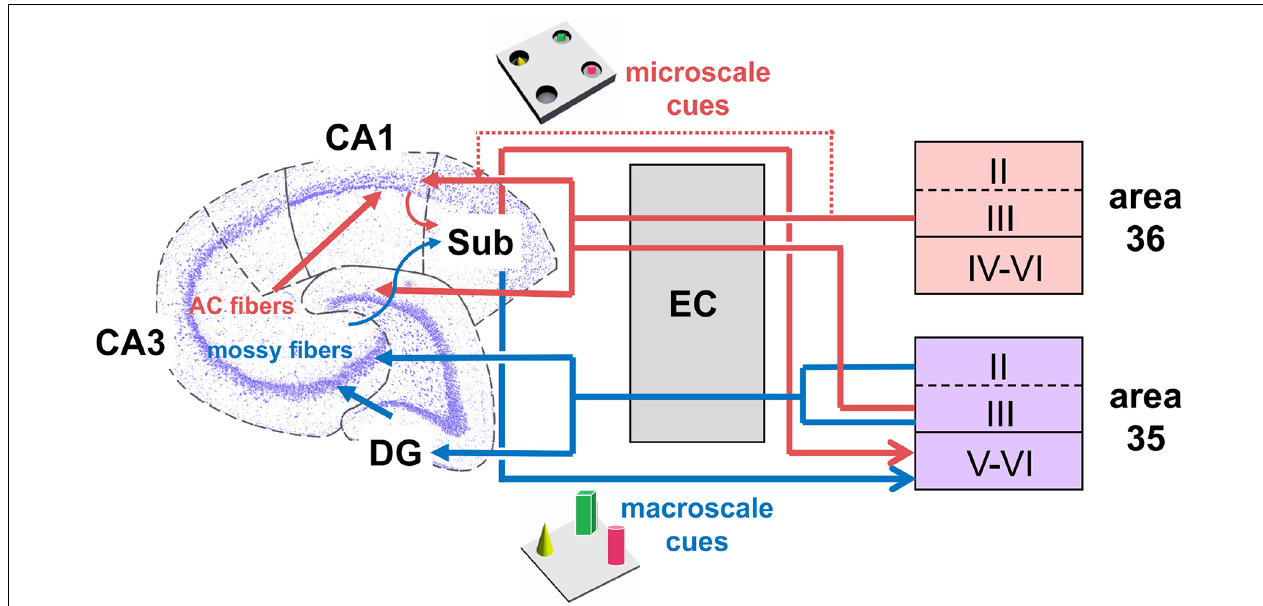
FIGURE 6 | Hypothesis of projections within hippocampal-perirhinal cortex circuits in novel object learning. Novel acquisition of item information (macroscale, blue) activates neuronal encoding in superficial and deep layers in area 35. Information about novel macroscale items may enter the entorhinal cortex through layers II and III of mostly area 35 before it reaches the hippocampus via the perforant path (Witter et al., 2000; Doan et al., 2019). In the hippocampus, the dentate gyrus and mossy fibers-CA3 synapses process this information (Kemp and Manahan-Vaughan, 2008; Hagena and Manahan-Vaughan, 2011; Hoang et al., 2018). The processed information may then be transferred to the subiculum, which presumably, in turn, sends information back to the deep layers of area 35 (Swanson and Cowan, 1977; Deacon et al., 1983; van Groen and Wyss, 1990; Kloosterman et al., 2003; Agster and Burwell, 2013). According to our results, area 36 does not support the encoding of this kind of information. If the item dimensions are small (microscale items, red), the Schaffer-collateral-CA1 and commissural-associational (AC)-CA3 synapses process this information (Kemp and Manahan-Vaughan, 2008; Hagena and Manahan-Vaughan, 2011; Hoang et al., 2018). Acquisition of microscale items (red) enhances neuronal activity in the superficial layer III of areas 35 and 36. This information may then be sent to the entorhinal cortex which in turn forwards the information to the Schaffer-collaterals-CA1 and AC-CA3 synapses in the hippocampus. In addition, information directly originating from the PRC superficial layers may be of particular importance for microscale information processing in CA1/subiculum (Agster and Burwell, 2013). Finally, the subiculum receives microscale item information that may be sent back to the deep layers of area 35 (Swanson and Cowan, 1977; Deacon et al., 1983; van Groen and Wyss, 1990; Kloosterman et al., 2003; Agster and Burwell,